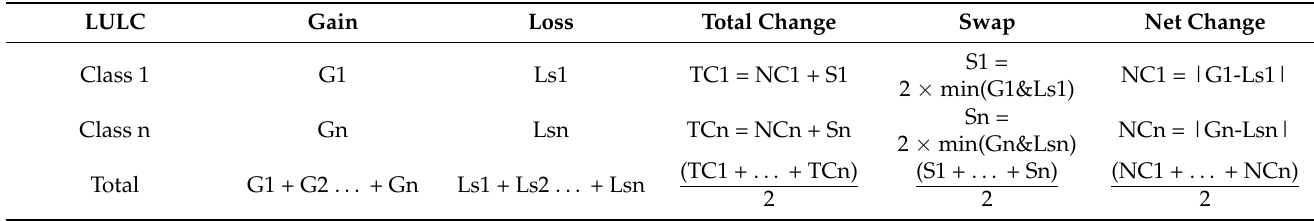
Table 1. Parameters of land use change. Based on the Pontius et al. (1929) methodology.